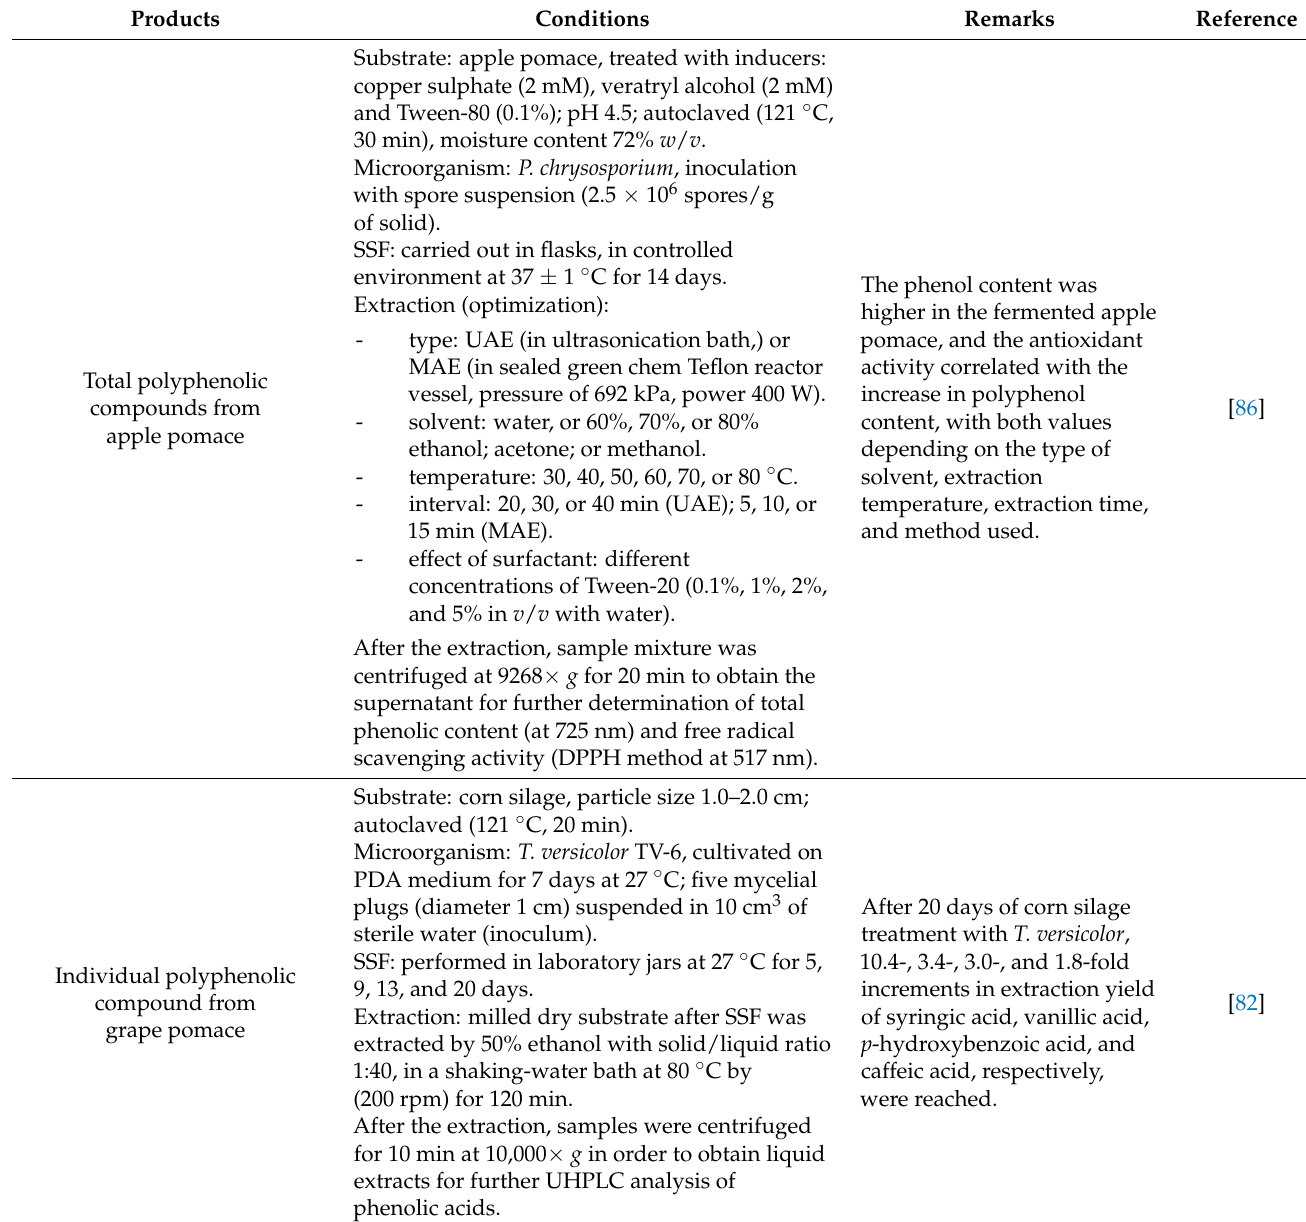
Table 7. Production of phenolic compounds from some food industry residues by SSF. Products